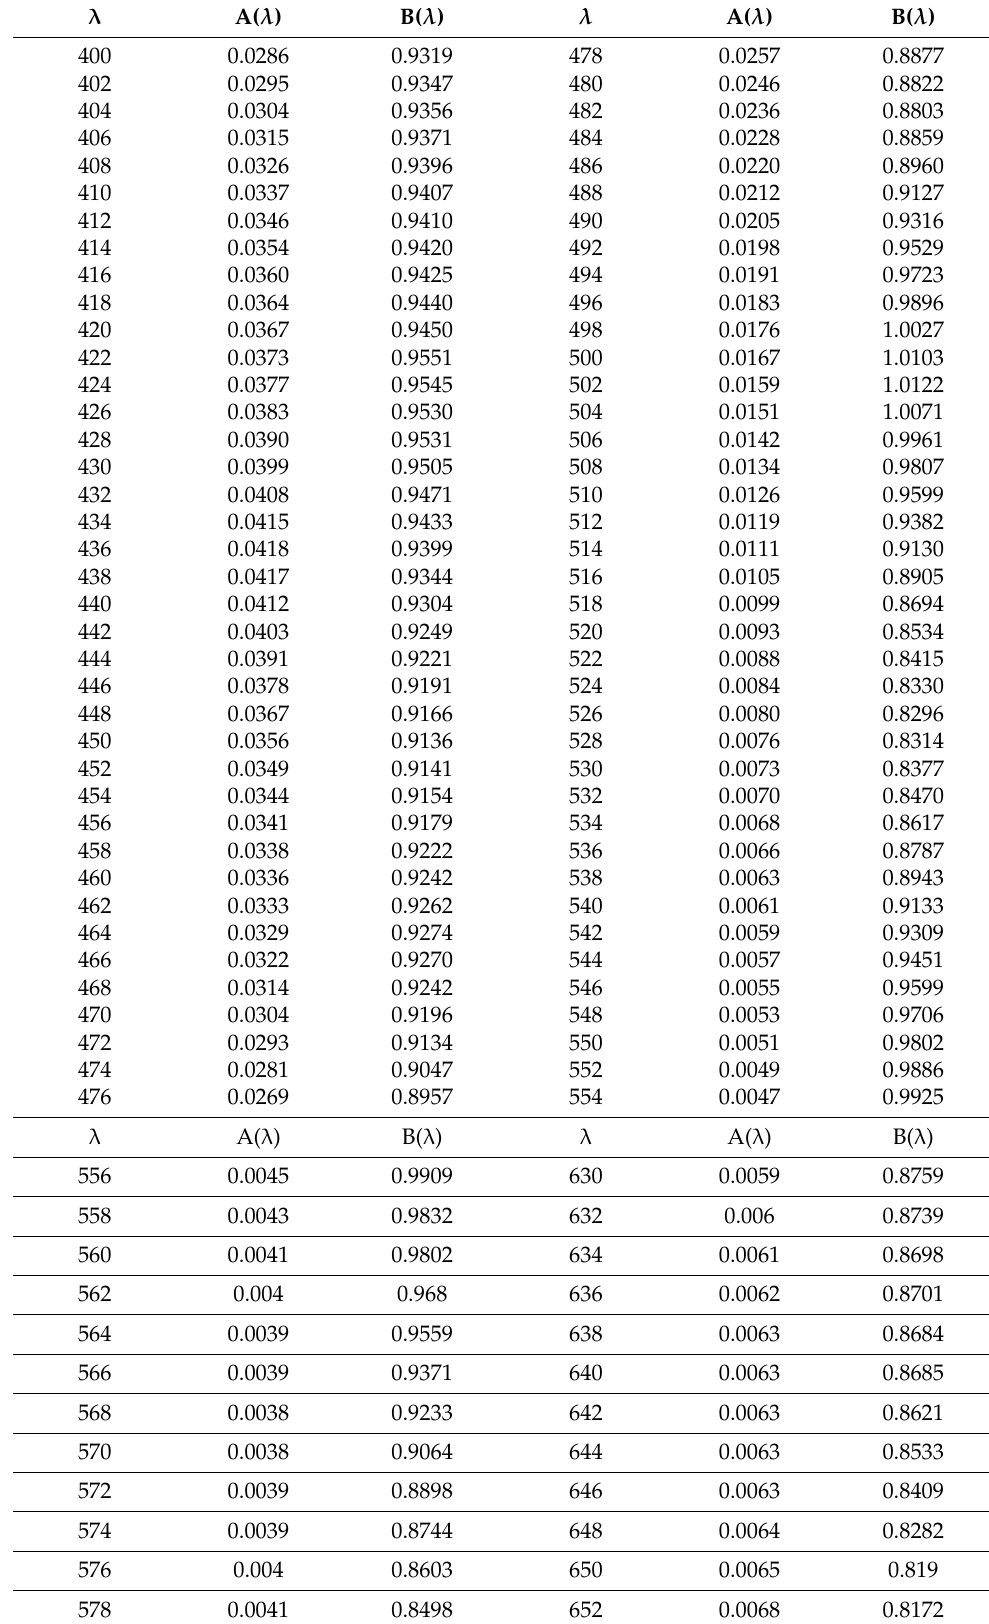
Table 2. Spectral values of the constants (A( λ ) and B( λ )) were obtained by fitting variations of a ph ( λ ) versus the Chl- a plus phaeopigment concentrations (TChl- a ) to power law as Equation